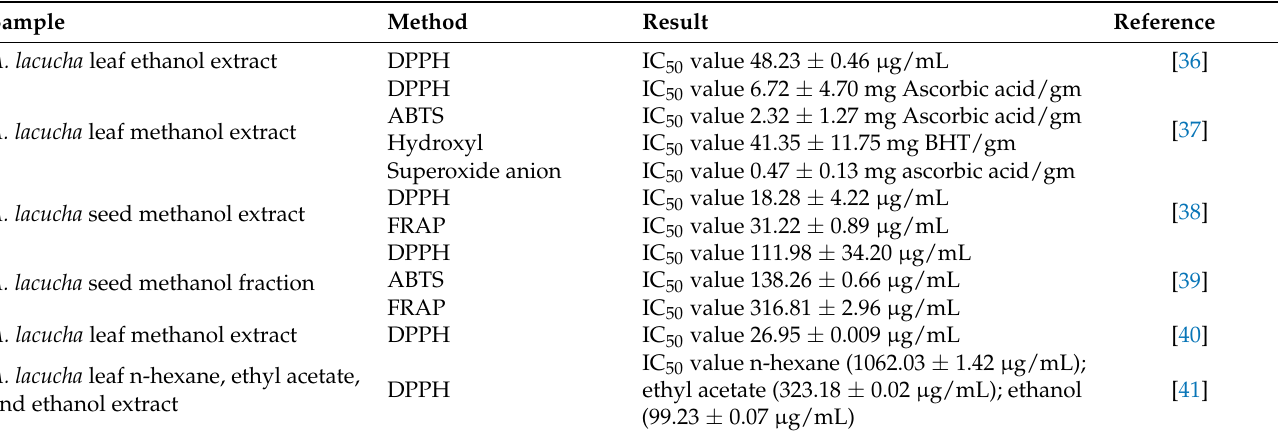
Table 2. Antioxidants of A. lacucha